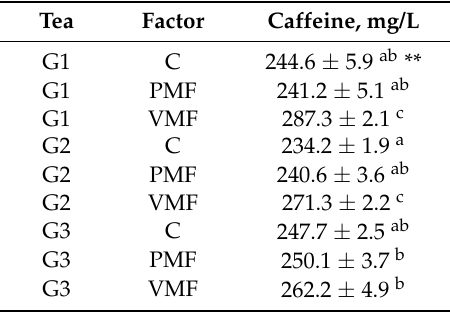
Table 4. Analytical findings showing contents of caffeine in green tea infusions extracted with the use of a magnetic field under control